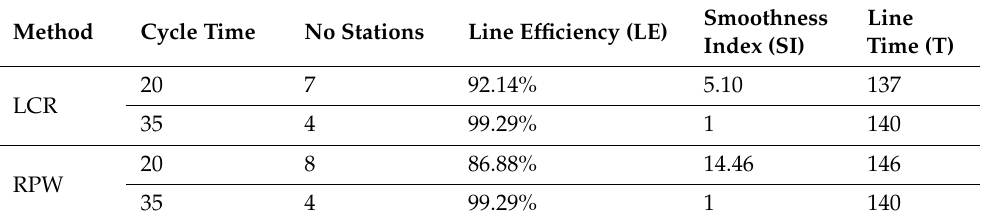
Table 5. Comparative analysis of the methods: largest candidate rule and ranked positional weight to balance the disassembly line dedicated to the complete